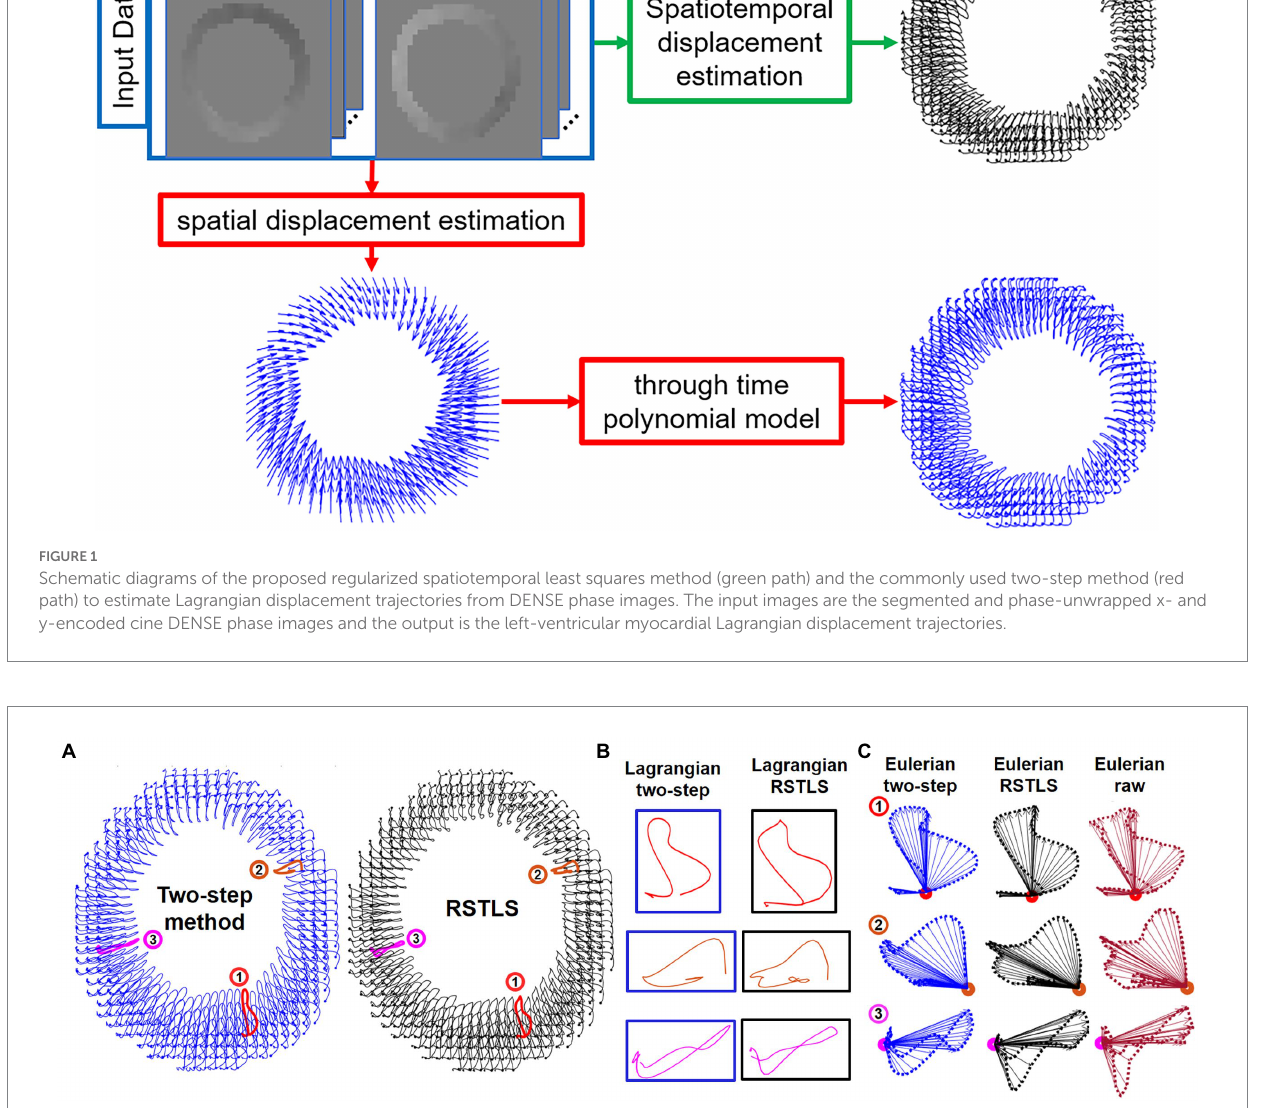
FIGURE 2 (A) An example of 2D Lagrangian displacement trajectories computed using the two-step method with a through-time polynomial function and the proposed regularized spatiotemporal least squares (RSTLS) method from a healthy subject. Panel (B) shows three magnified example Lagrangian trajectories computed with both the two-step and RSTLS methods, and panel (C) shows the same magnified trajectories projected to the Eulerian domain. The raw Eulerian trajectories (at all discrete time points) calculated directly from the unwrapped DENSE phase data are also shown in (C) . These examples demonstrate that abrupt changes in trajectories are over-smoothed using the two-step method but are better depicted using the RSTLS method. The Lagrangian trajectories projected into the Eulerian domain show that RSTLS maintains better agreement than the two-step method with the raw Eulerian